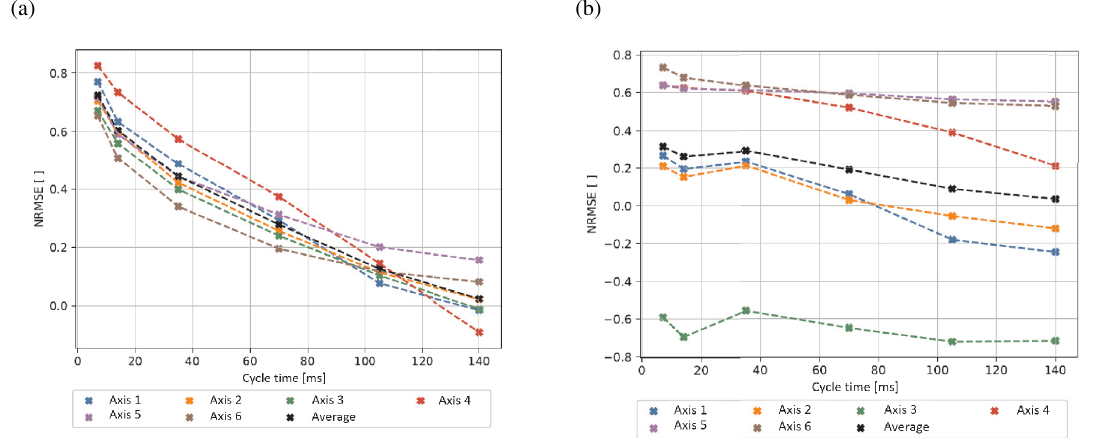
Fig. 2. difNRMSE of (a) velocity and (b) position at ffferent virtual cycle times in